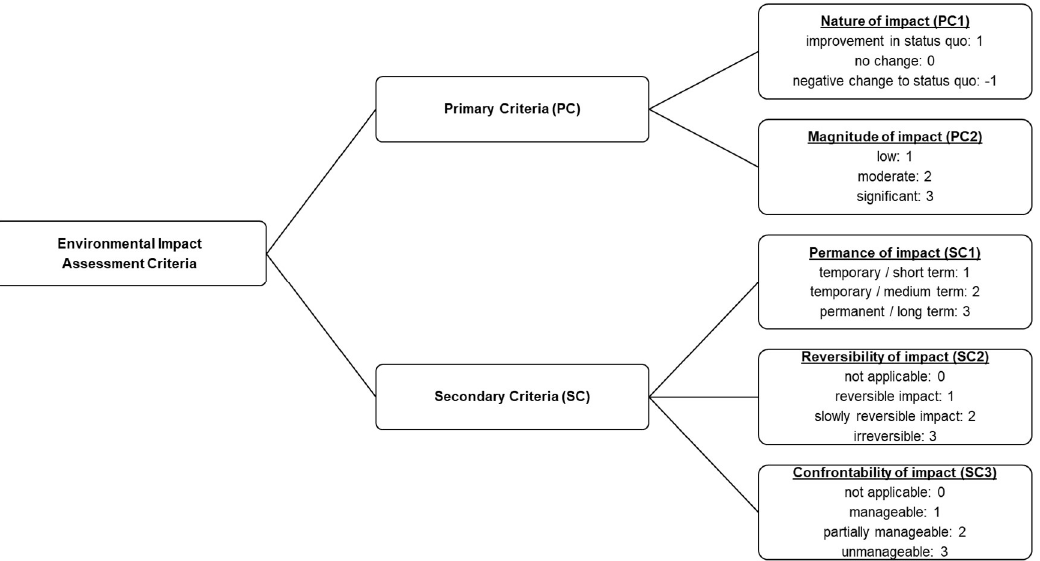
Figure 1. Environmental Impact Assessment (EIA) criteria and their scaling.